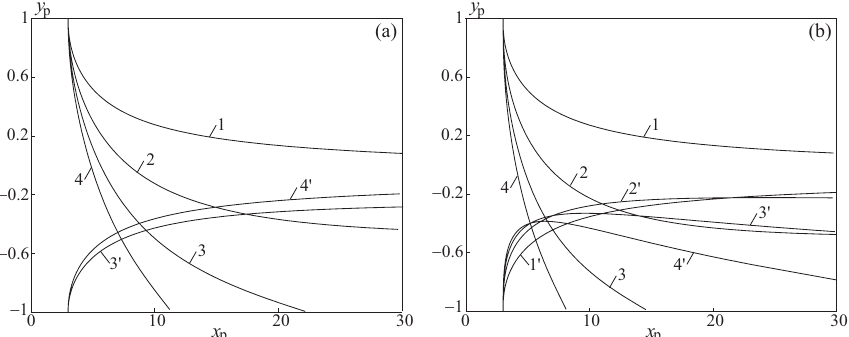
Figure 10. Trajectories of particle for v p0 = 0 ( a ) and v p0 = 1 ( b ) with different Stokes numbers Stk = 0.1 (1); 0.5 (2); 1.0 (3); 1.5 (4).